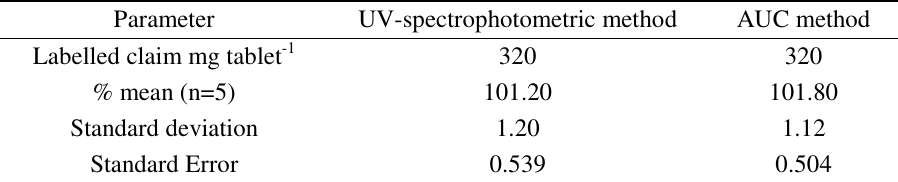
Table 2. Result of analysis of commercially available tablet of gemifloxacin mesylate byUV-spectrometric and AUC method.